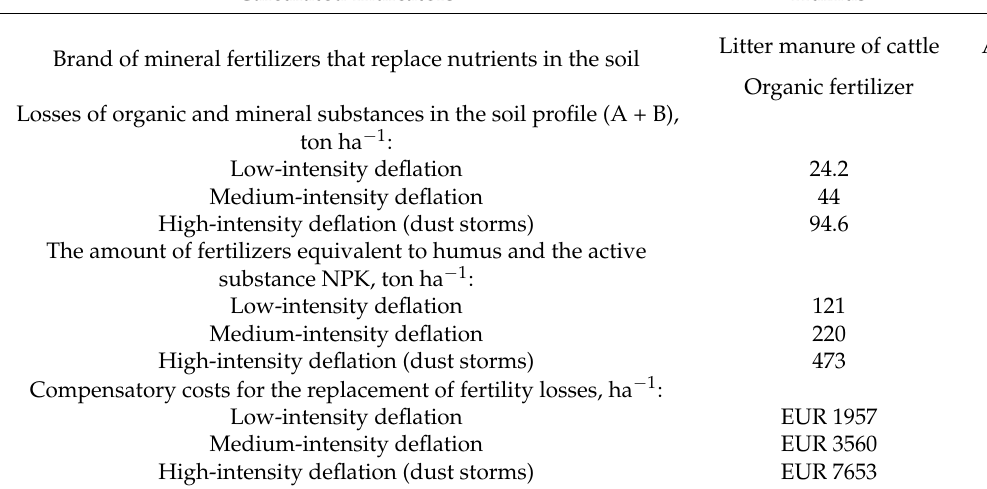
Table 1. Annual ecological and economic damage from the loss of nutrients of ordinary chernozems as a result of wind erosion. Calculated